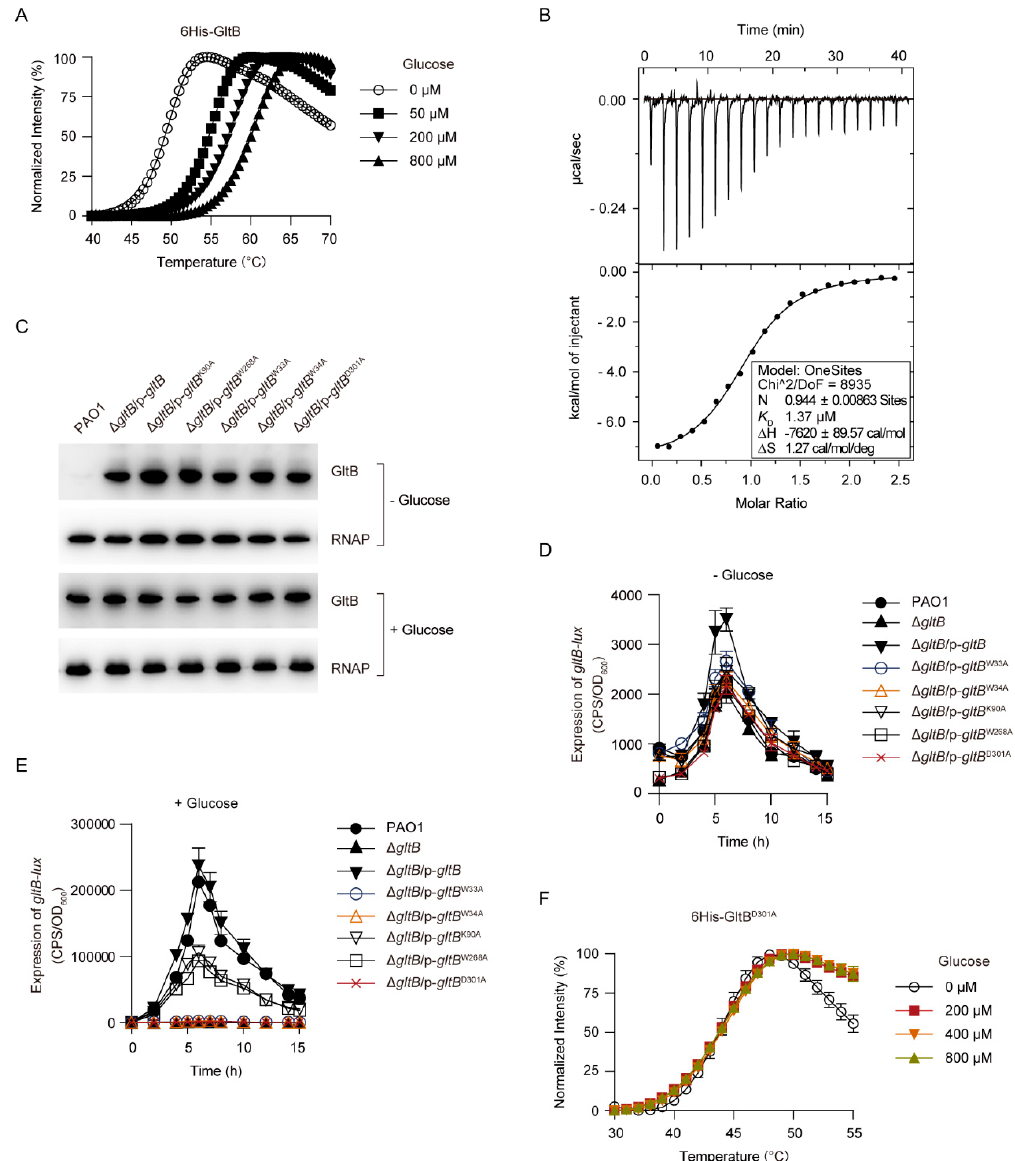
Figure 6. Role of glucose-binding residues on the regulatory function of GltB. ( A ) Thermal melt curves of 5 µ M 6His-GltB in the presence of indicated glucose concentrations. ( B ) Isothermal titration calorimetry of 6His-GltB (17 µ M) with glucose (200 µ M). Upper panel, raw data output; lower panel, plot of integrated heats versus the glucose/6His-GltB ratio. Data was fitted with a one-site model. The fitted results are displayed: N refers to the stoichiometry of GltB-glucose complex, K D refers to the equilibrium dissociation constant, ∆ H (reaction enthalpy) and ∆ S (entropy) are the thermodynamic parameters. ( C ) Western blot images showing the production of GltB and its variants. Protein samples were derived from bacteria grown in tubes containing M8 MM in the absence ( − ) or presence (+) of 10 mM glucose at 37 ◦ C for 6h with shaking (250rpm). RNAP subunit is probed as a loading control. Experiments were repeated at least three times with similar results and the figures show a set of representative data. ( D , E ) Expression of gltB-lux in P. aeruginosa strains cultured in 96-well plates containing M8 MM supplemented with (+) or without ( − ) 10 mM glucose. Data from n = 3 biological replicates reported as mean ± SD. In (D and E), PAO1 and ∆ gltB harbor an empty pAK1900 vector as control; p- gltB denotes the pAK1900- gltB plasmid; p- gltB W33A , p- gltB W34A , p- gltB K90A , p- gltB W268A , and p- gltB D301A denote the pAK1900- gltB W33A plasmid, the pAK1900- gltB W34A plasmid, the pAK1900- gltB K90A plasmid, the pAK1900- gltB W268A plasmid, and the pAK1900- gltB D301A plasmid, respectively (Table S1). ( F ) Thermal melt curves of 5 µ M 6His-GltB D301A in the presence of indicated glucose concentrations. In (A) and (F), fluorescence signals of all samples have been normalized to relative values of 0% (the lowest fluorescence signal) and 100% (the highest fluorescence signal),